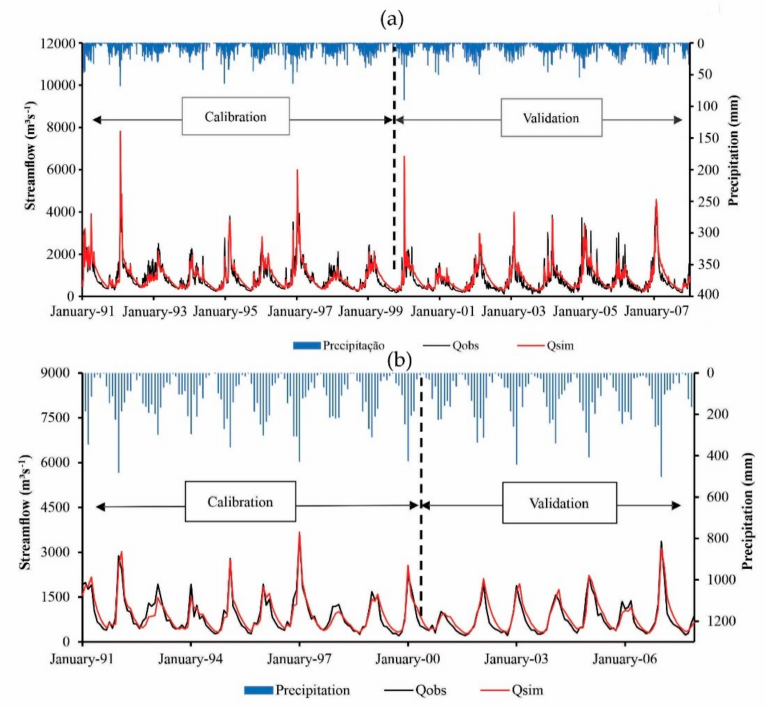
Figure 4. Observed and estimated daily ( a ) and monthly ( b ) hydrographs and respective hyetographs in the GRB-Furnas basin for calibration and validation of the LASH